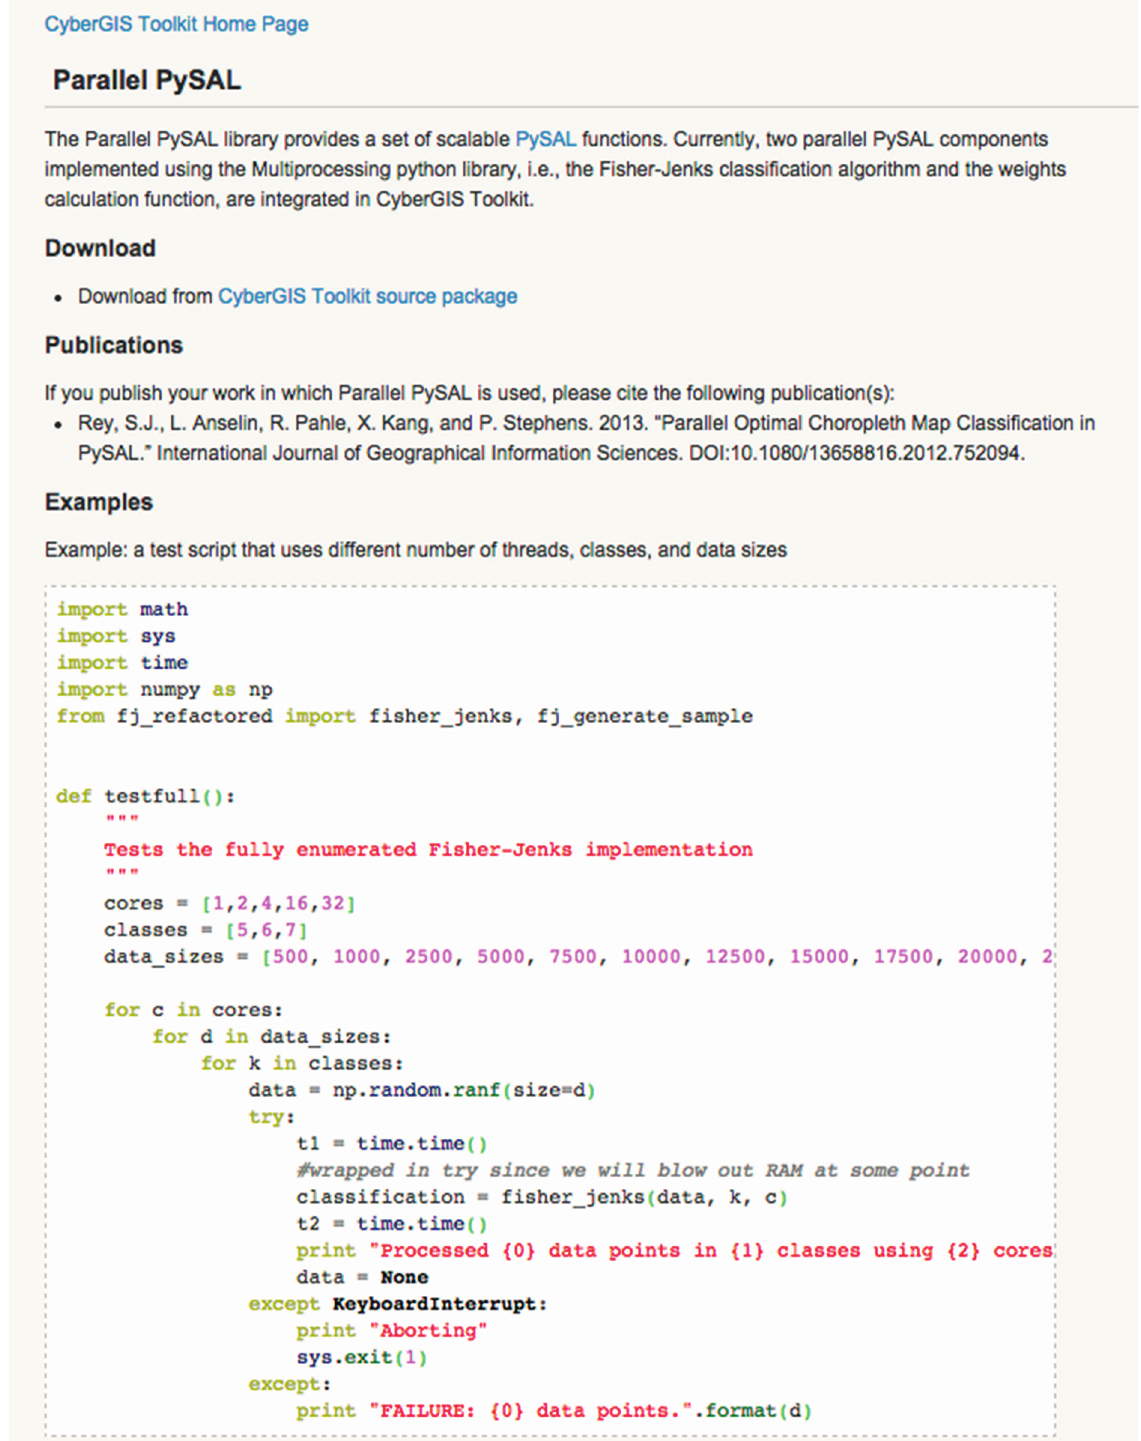
Figure 9. Parallel PySAL in the CyberGIS